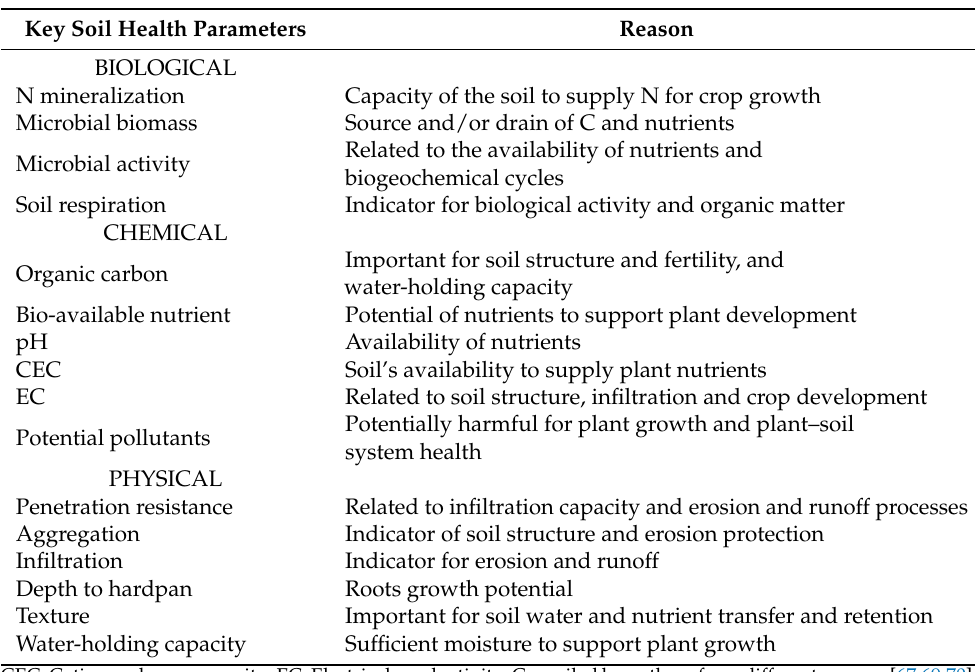
Table 2. Minimum data set (MDS) for soil health